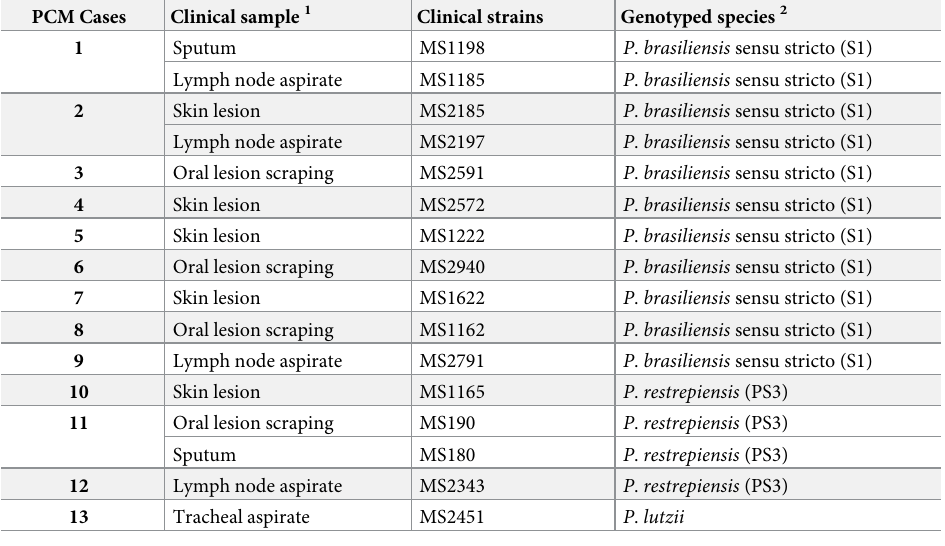
The genotyping ( tub1 -PCR-RFLP) of these clinical isolates revealed the occurrence of three different Paracoccidiodies species: P . brasiliensis sensu stricto (S1) (11/16), P . restrepiensis (PS3) (4/16) and P . lutzii (1/16) ( Table 2 and S2 Fig ). All PCM cases described in this study (n = 13) are of patients currently living in Mato Grosso do Sul, Brazil. Nine of them (9/13; 69.2%) were infected by P . brasiliensis sensu stricto (S1), three (3/13; 7.7%) by P . restrepiensis (PS3) and just one (1/13; 7.7%) by P . lutzii . The Table 2. Molecular identification of Paracoccidioides clinical strains in Mato Grosso do Sul, Brazil